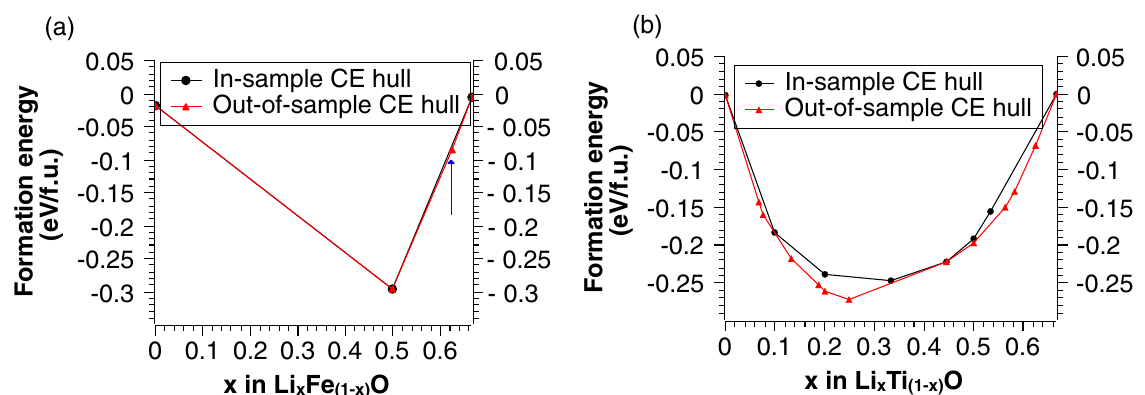
Fig. 4 Comparison of the convex hulls based only on the reference input data (in-sample CE hull) and based on all ground-state con fi gurations of the cluster expansion model (out-of-sample CE hull) for ( a ) Li x Fe (1 − x ) O and ( b ) Li x Ti (1 − x ) O. The Li x Ti (1 − x ) O out-of-sample hull is below the in-sample hull with a maximal distance of 6 meV. An arrow is added to emphasize the out of sample ground-state at x = 0.625 for